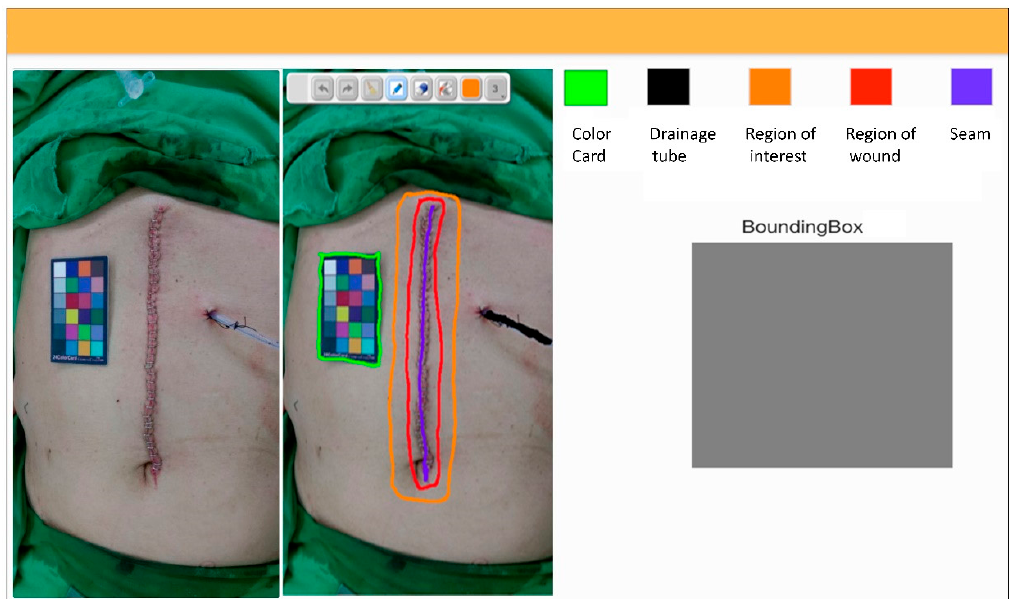
Figure 1. Annotation page for wound region of interest (ROI) annotation (left: without annotation; right: with annotation).